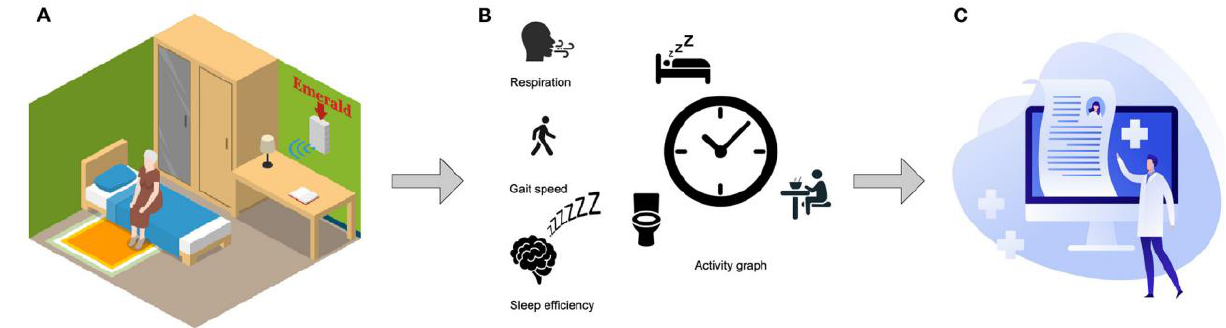
Figure 2. The Emerald RF sensor. Picture ( A ) shows the analogy with a Wi-Fi router. in the picture ( B ), recording of respiration, gait speed, sleep efficiency and daily activities patterns are collected. Finally, the picture ( C ) exhibits the possibility for qualified clinicians to remote acquire the recorded data (Reproduced under the terms and conditions of the Creative Commons Attribution (CC BY) license from [61]).